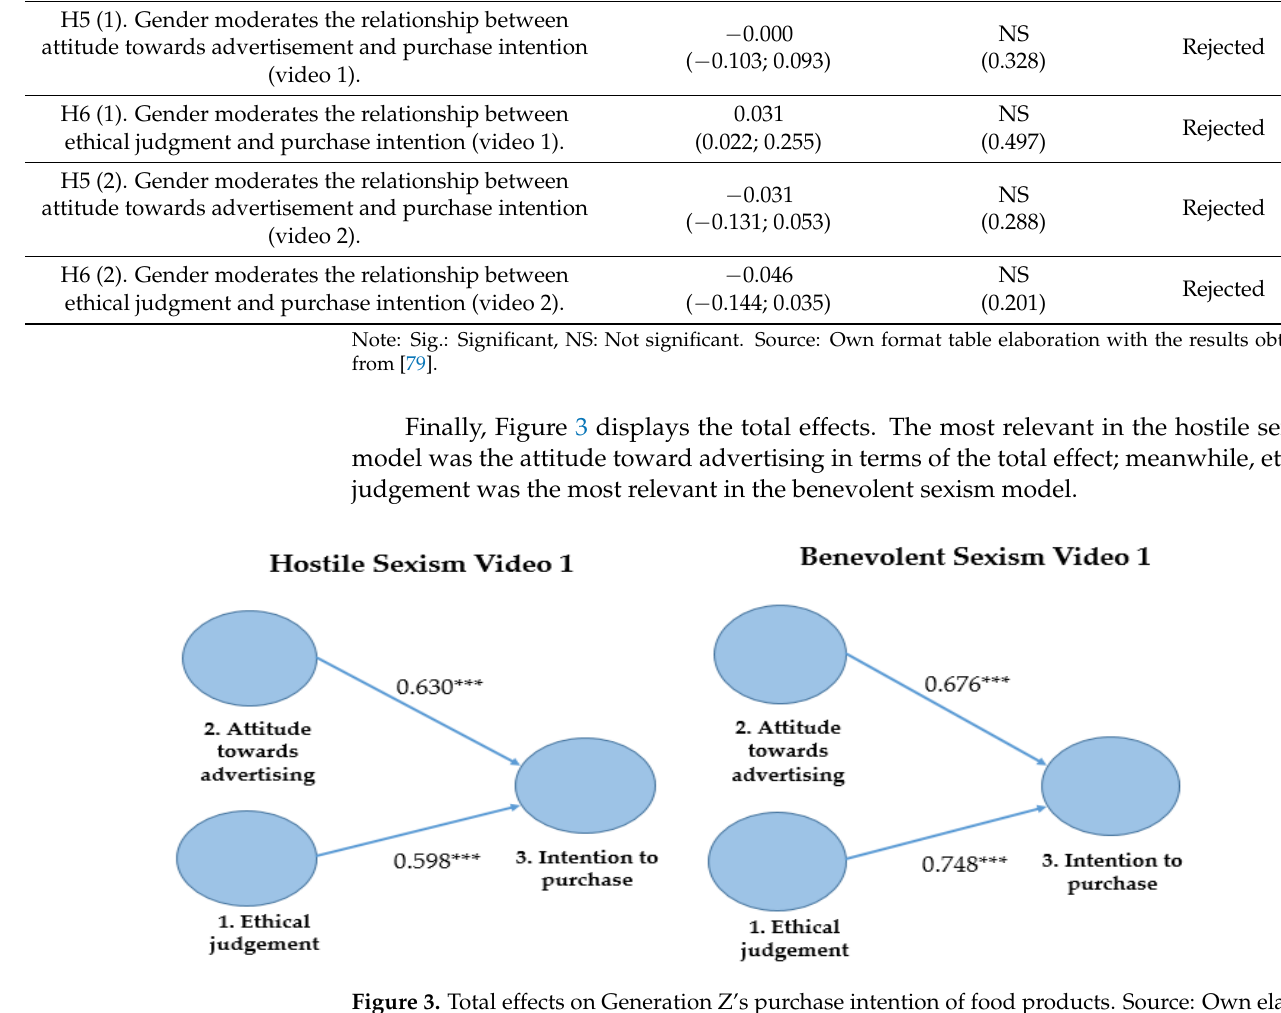
Figure 3. Total effects on Generation Z’s purchase intention of food products. Source: Own elaboration based on results from [79]. Note. *** p < 0.001.